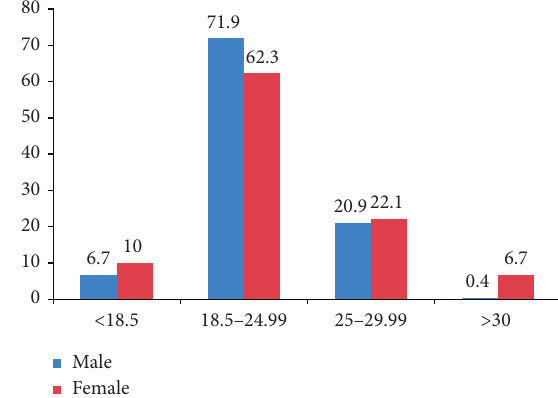
Figure 1: Classification of nutritional status using body mass index (BMI) among adults in Addis Ababa, Ethiopia.